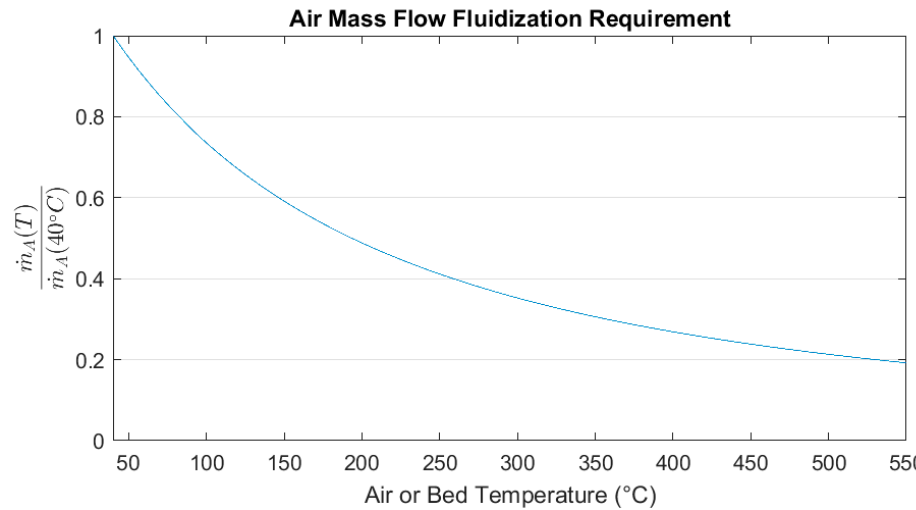
Figure 24. Required fluidization air mass flow depending on temperature relative to 40 °C.